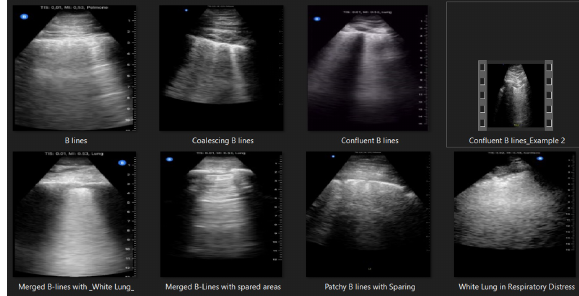
Fig. 4. Samples of LUS dataset is provided for